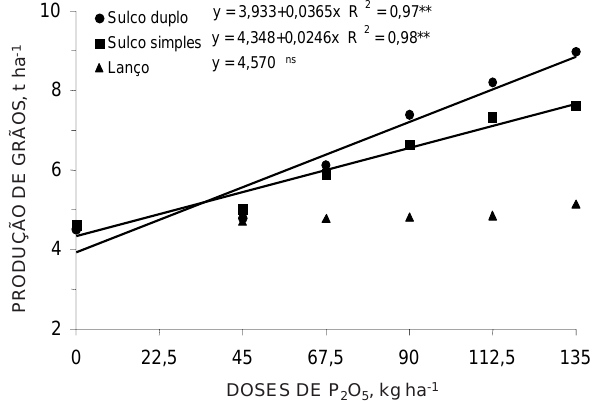
Figura 2. Efeito dos modos de aplicação do fertilizante fosfatado em sulco simples e sulco duplo na produção de grãos da cultura do